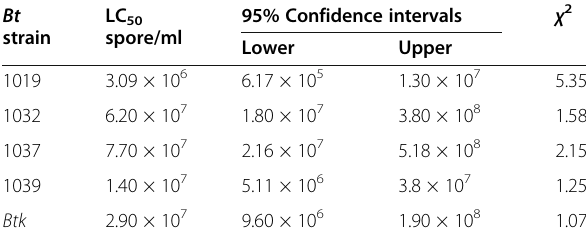
Table 2 Mean lethal concentrations (LC 50 ) of Ephestia kuehniella infected with some Iranian Bacillus thuringiensis strains Bt